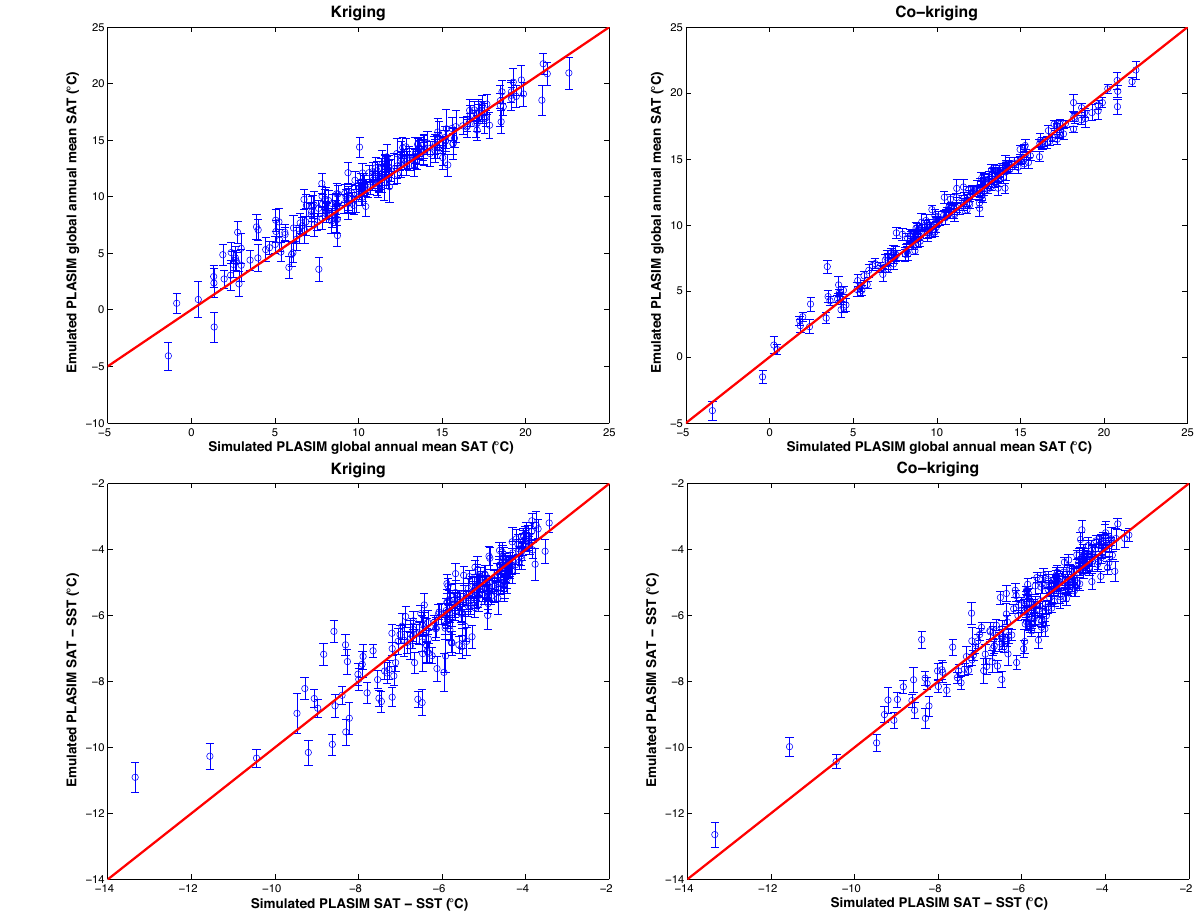
Figure 4. The upper panels show PLASIM simulated global mean SAT at the 214 validation points plotted against their emulated values from both kriging (left) and co-kriging (right) emulators. The error bars indicate a 2 standard deviation interval at each point. The lower panels show the results of the global mean SAT–SST